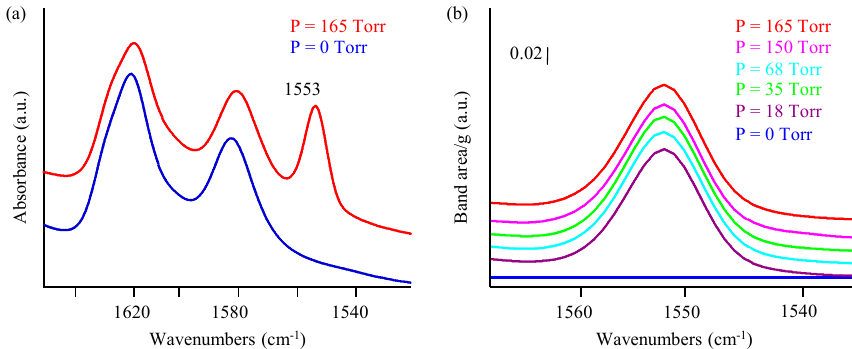
Figure 5. ( a ) IR spectra of as synthesized Na-X at 0 and 165 Torr O 2 and ( b ) evolution of IR band at 1553 cm − 1 corresponding to O 2 adsorbed on the Na-X at different pressures (T = − 196 °C).